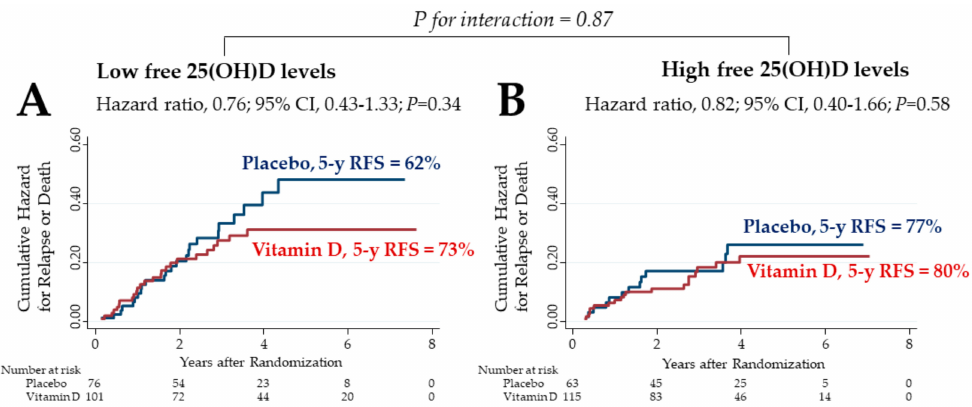
Figure 4. Nelson–Aalen cumulative hazard curves for relapse or death in the subgroups of free 25(OH)D levels lower ( A ) and higher ( B ) than median levels (5.70 pg / mL) before starting supplementation. 25(OH)D: 25-hydroxyvitamin D; CI: confidence interval; 5 y RFS: 5 year relapse-free